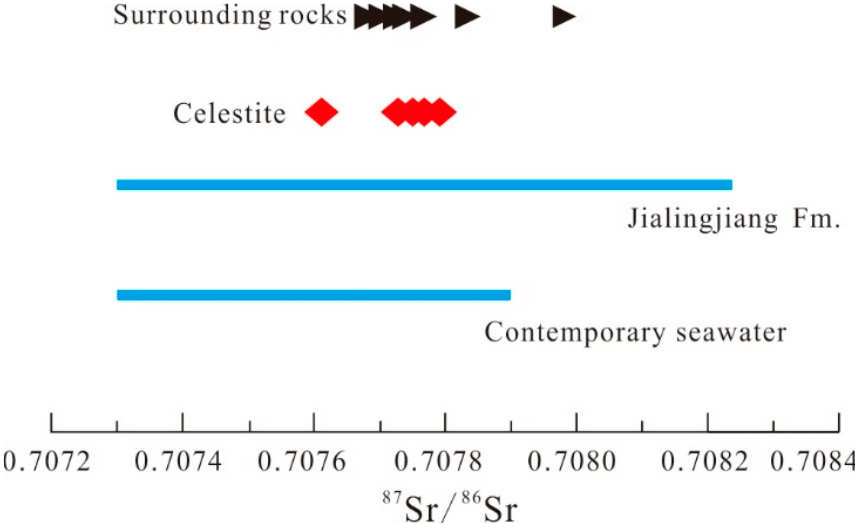
Figure 11. Sr isotopic compositions of celestine and host rocks. Sr isotope data of the Jialingjiang Formation and contemporaneous seawater are obtained from [72,73].